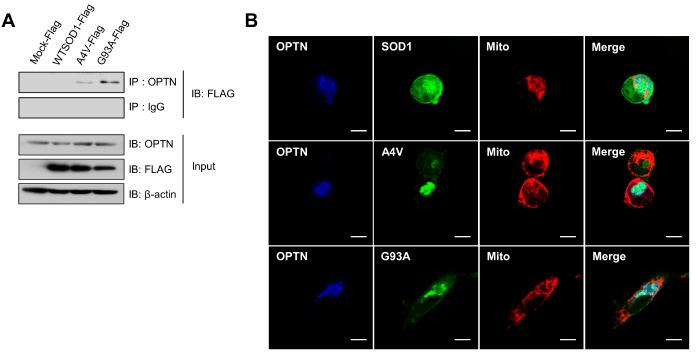
Figure 1. Optineurin associates with the mutant SOD1 proteins, A4V and G93A. ( A ) Immunoprecipitation assay for SOD1 and endogenous OPTN in N2a cells expressing SOD1-FLAG, A4V-FLAG, G93A-FLAG, or FLAG empty vectors. At 48 h after transfection, each sample was immunoprecipitated with OPTN antibodies and immunoblotted with FLAG antibodies. ( B ) N2a cells expressing DsRed-mito, which detects mitochondria, together with SOD1-GFP, A4V-GFP, or G93A-GFP, were immunostained with OPTN antibodies at 48 h after transfection. Scale bar = 10 μ M.